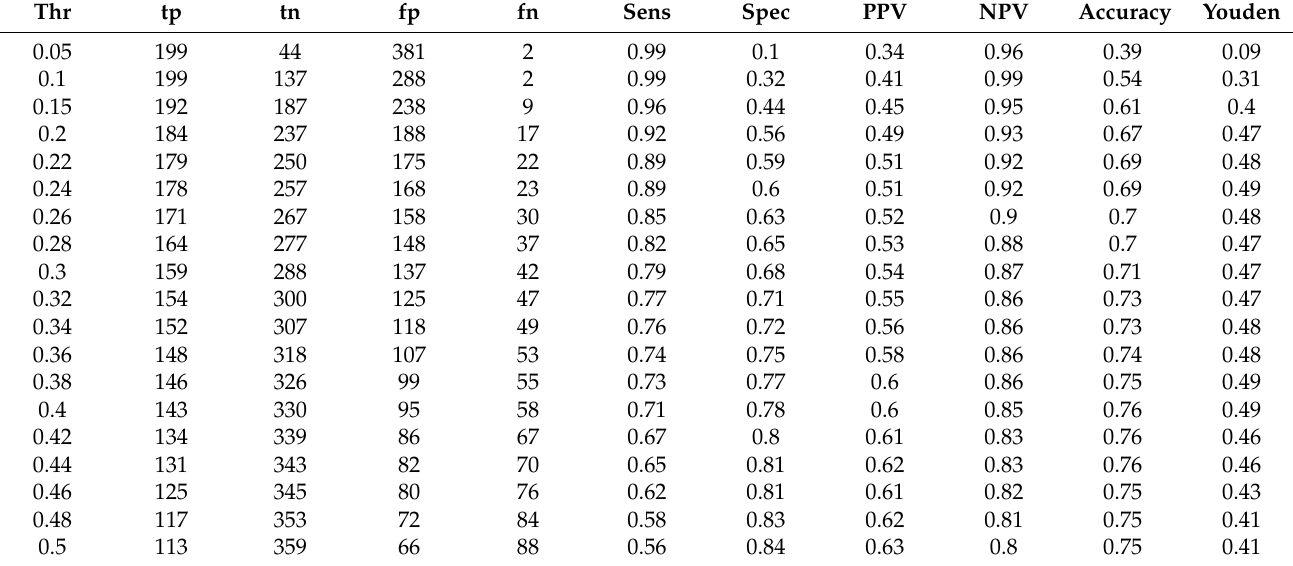
Figure 9. ROC curve for the external validation dataset. The clinical utility analysis of the model is given in Table 5. For each probability threshold, the following metrics are presented: sensitivity (3), specificity (2), PPV (5), NPV (6), and accuracy (1). The cut-offs of 0.24 and 0.4 equally optimize the Youden index (4). However, if minimization of both classification errors is desired, a 0.4 threshold gives us more balanced (0.71 and 0.78) sensitivity (3) and specificity (2) values. Table 5. Cut-off analysis of the external validation cohort (November 2020–January